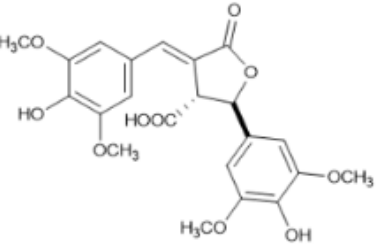
Figure 4. Chemical structures of the synthesized HCAs in reaction mixtures with copper ion.